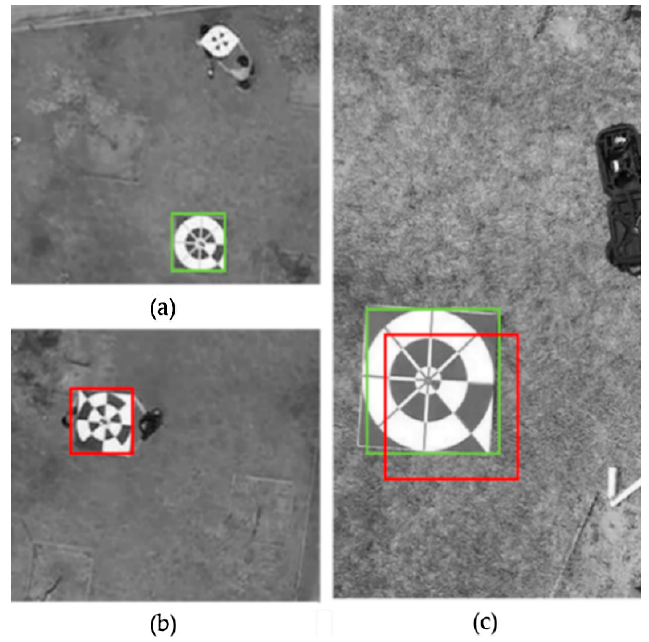
Figure 12. Examples of the detected results. The green boxes are ground truth labels; the red boxes are detected results. ( a ) The model cannot detect the maker on the image, and thus this case is considered as FN. ( b ) The detected result is not the marker but rather a marker-like object, and therefore this case is considered as FP. ( c ) The model can correctly detect the marker on the image; this case is considered as TP if the IoU is greater than or equal to the predefined threshold; otherwise, it is considered as FN and FP.